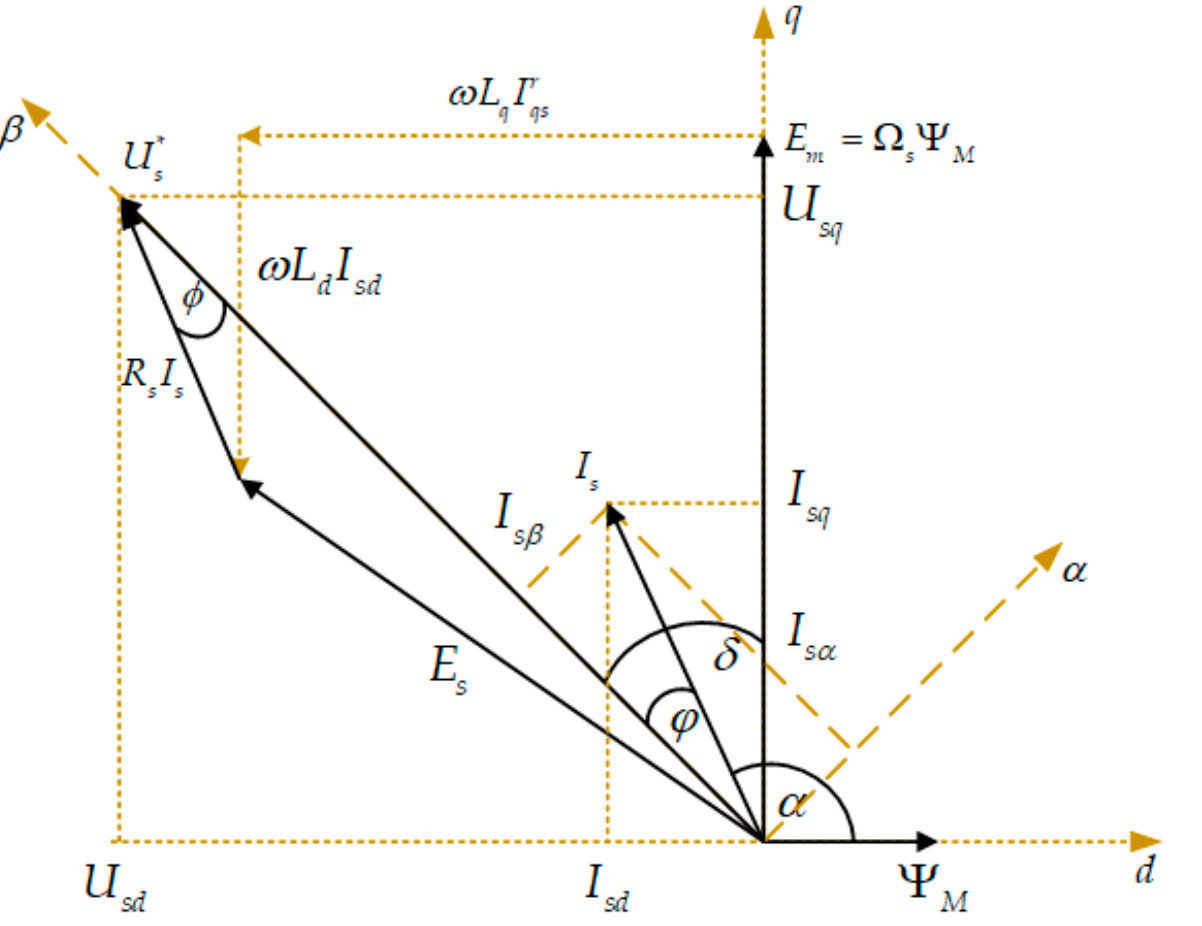
Figure 4. Vector diagram of PMSM for steady-state.